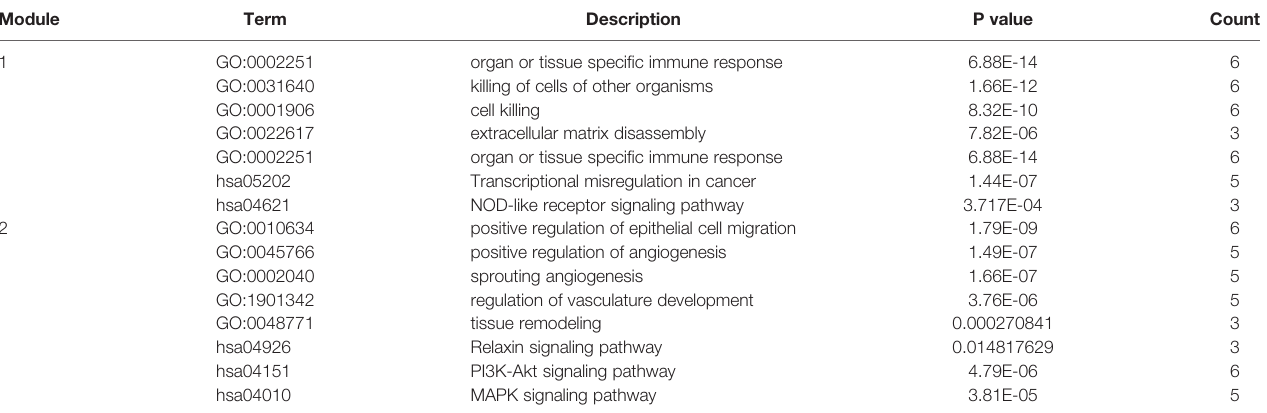
TABLE 1 | Functional and pathway (GO, KEGG) enrichment analysis of MCODE identi fi ed sub-networks.